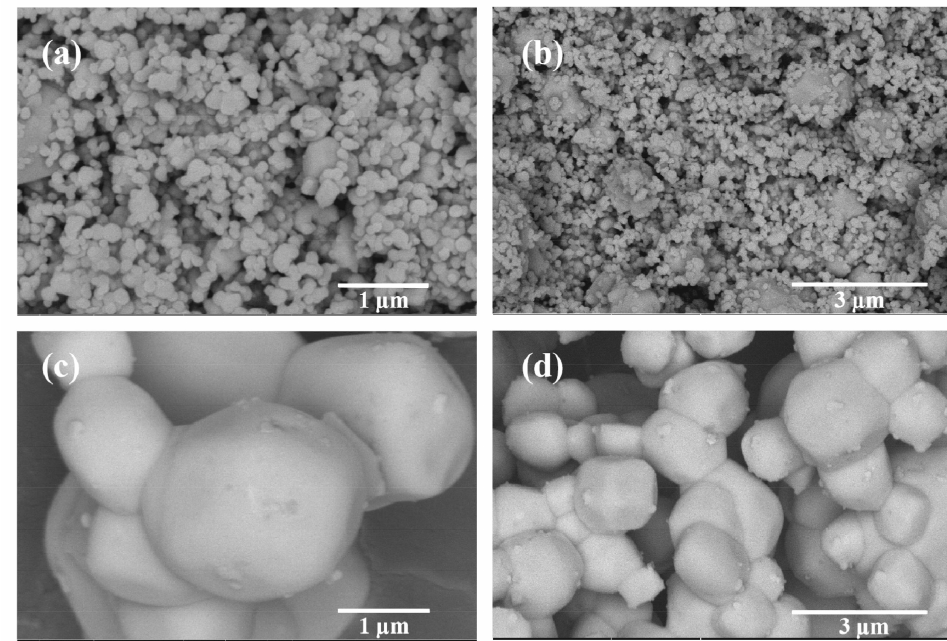
Figure 2. SEM images of ( a,b ) Ag 3 PO 4 and ( c,d ) IL-Ag 3 PO 4 .